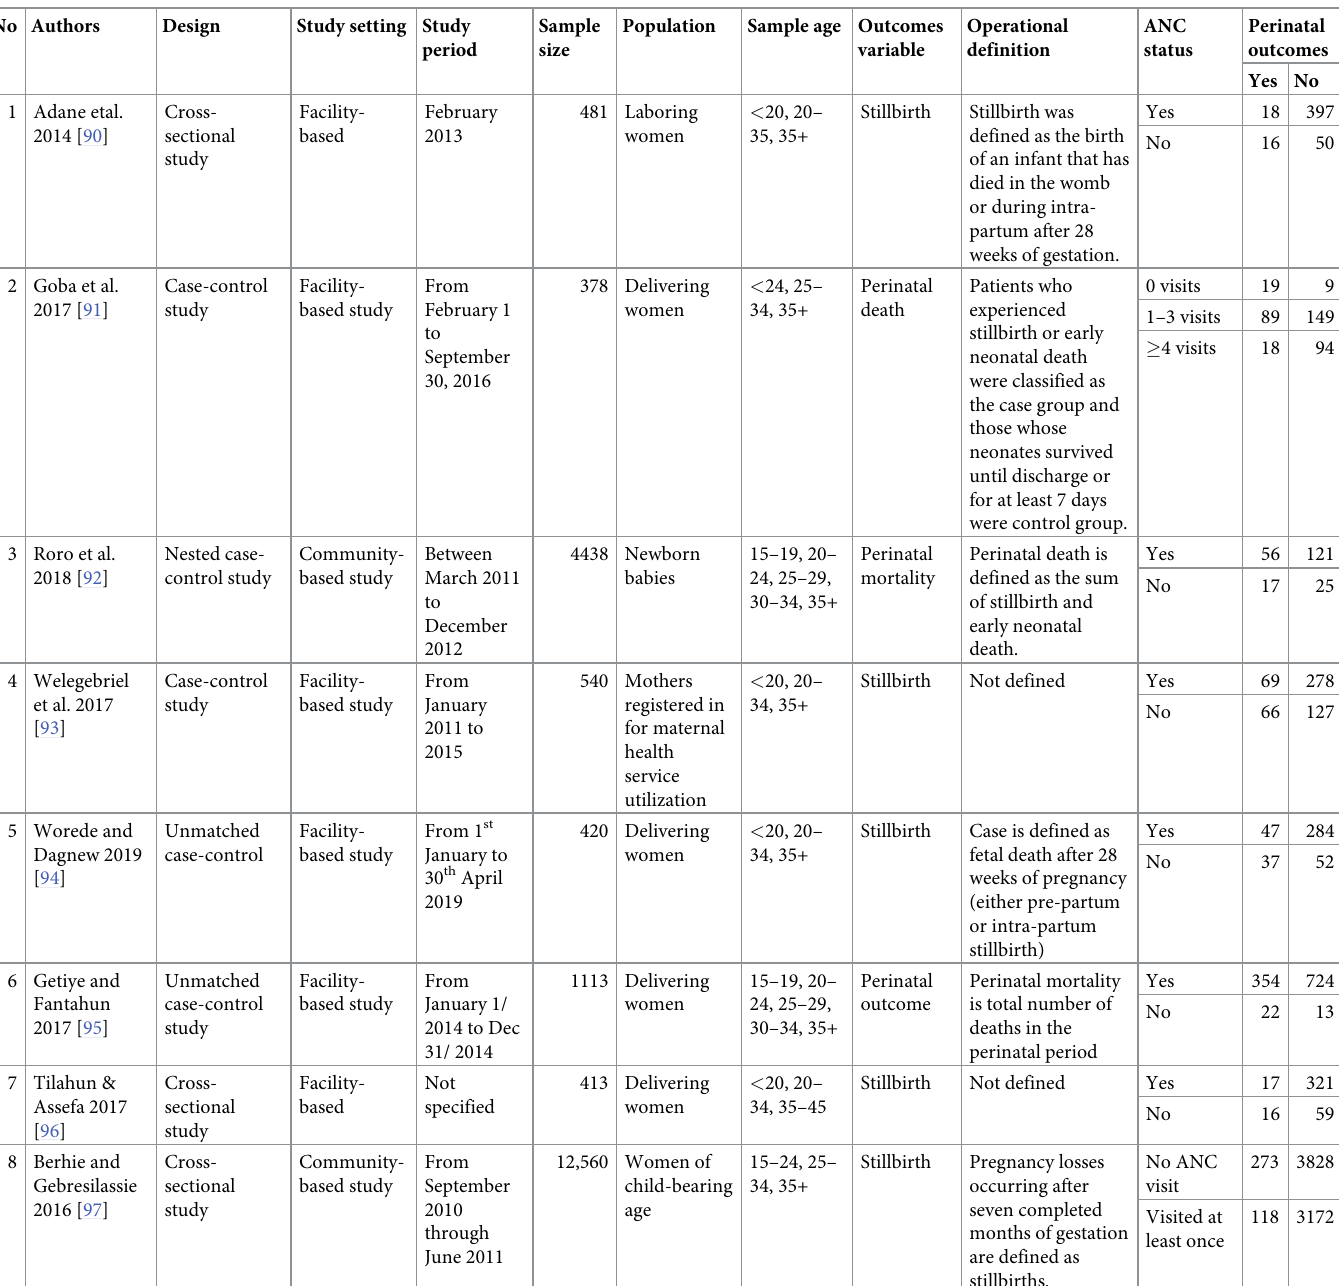
Table 1. Characteristics of studies revealing the effect of ANC on perinatal outcomes in